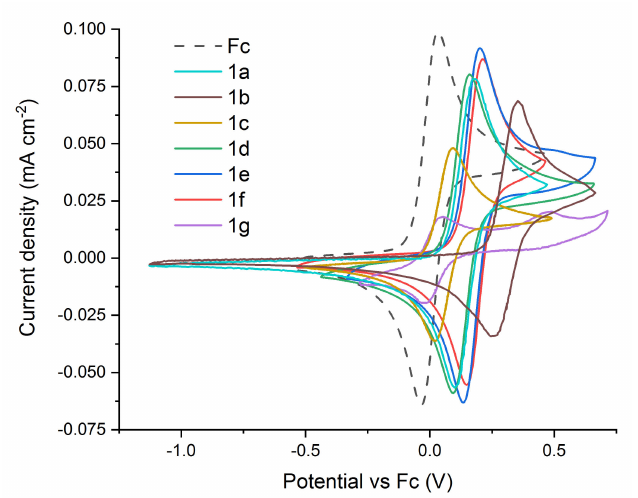
Figure 3. Cyclic voltammograms of compounds 1a–1g (solid lines) and ferrocene as reference (dashed line) in 0.1 M TBAClO 4 in MeCN at a scan rate of 100 mV s − 1 . The working, counter, and the pseudo-reference electrodes were a gold pin, a Pt wire, and an Ag / AgCl electrode (3 M KCl),